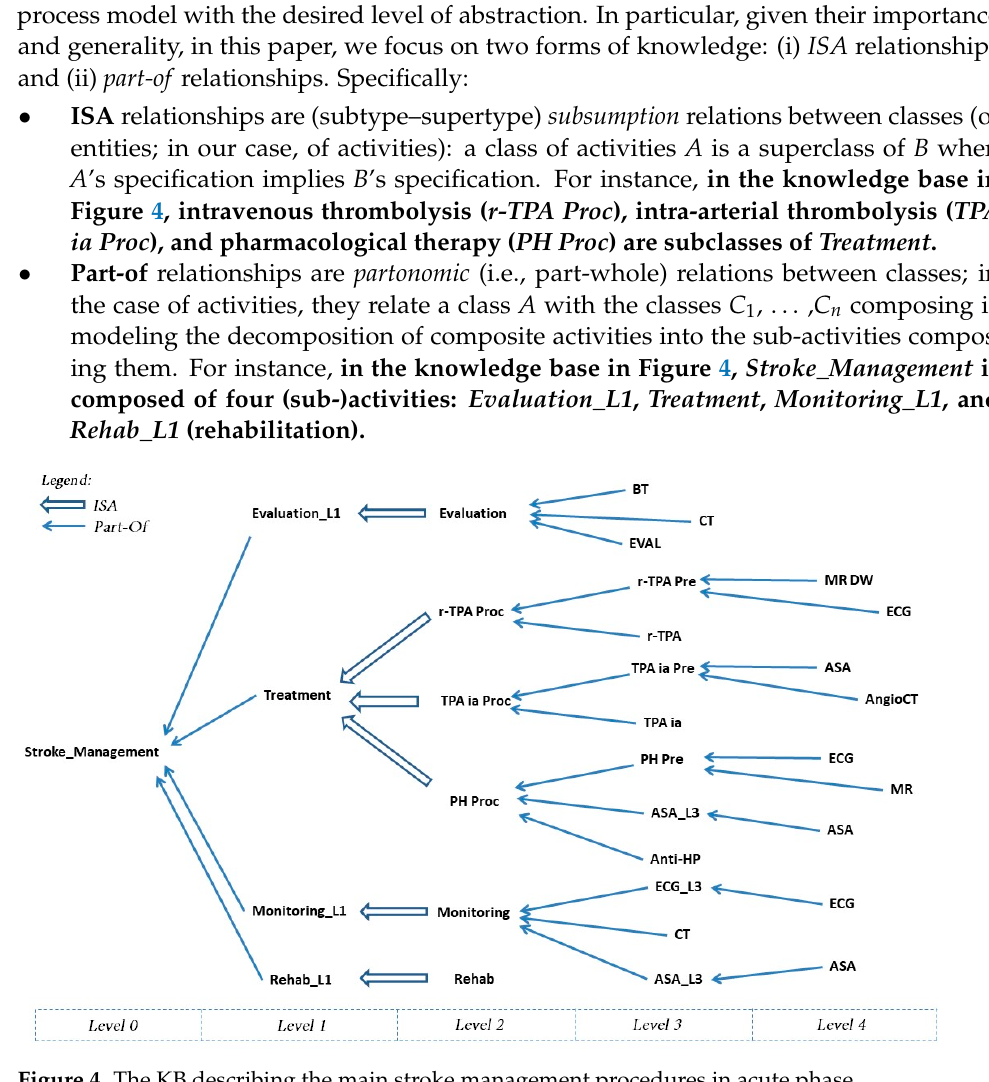
Figure 4. The KB describing the main stroke management procedures in acute phase.